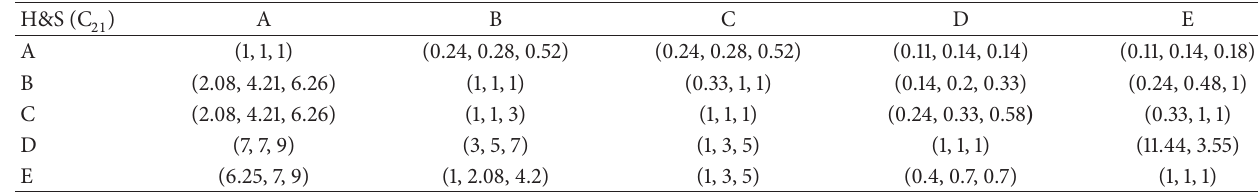
Table 7: Options concerning H&S